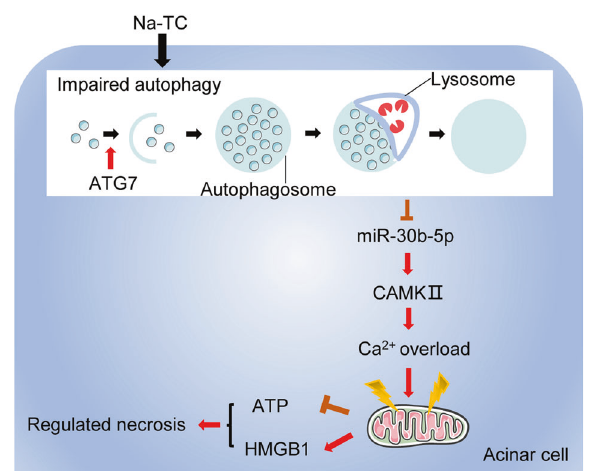
Fig. 6 Schematic presentation of the mechanism involved in the promotion of regulated necrosis in response to ATG7-enhanced impaired autophagy in our AP model. AP acute pancreatitis, ATP adenosine triphosphate, CAMKII calcium/calmodulin-dependent protein kinase II, HMGB1 high mobility group protein B1, Na-TC sodium